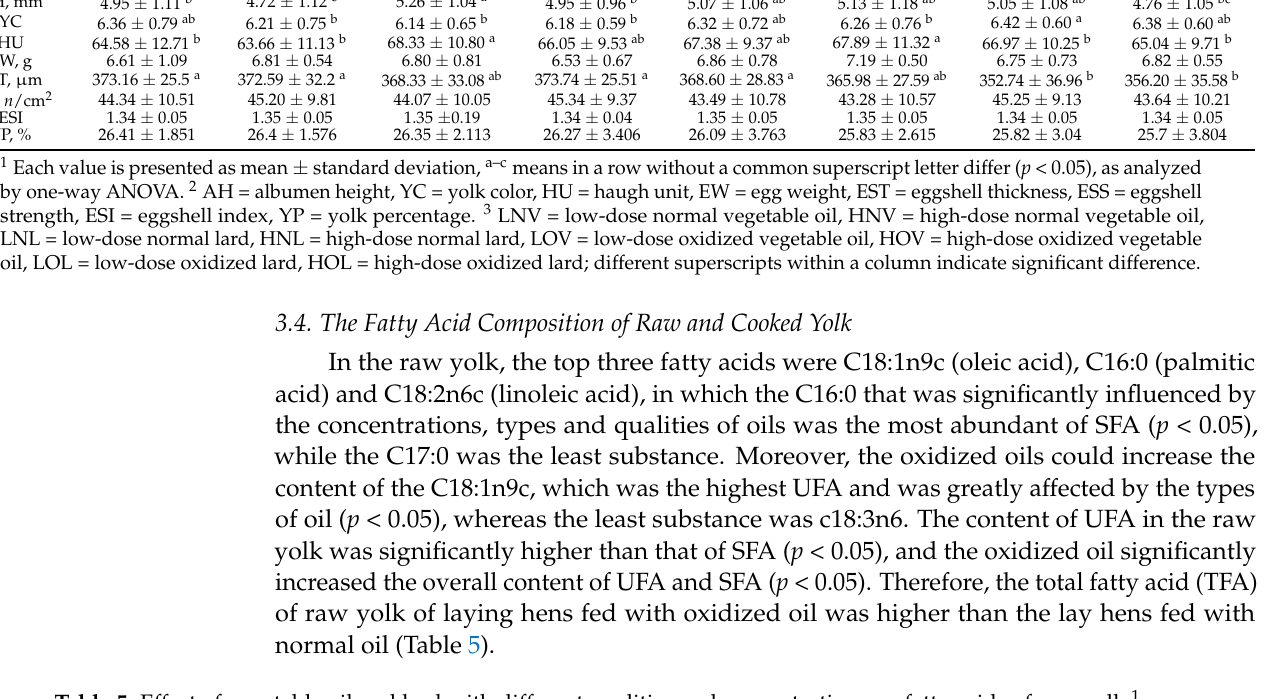
Table 5. Effect of vegetable oil and lard with different qualities and concentrations on fatty acids of raw yolk 1